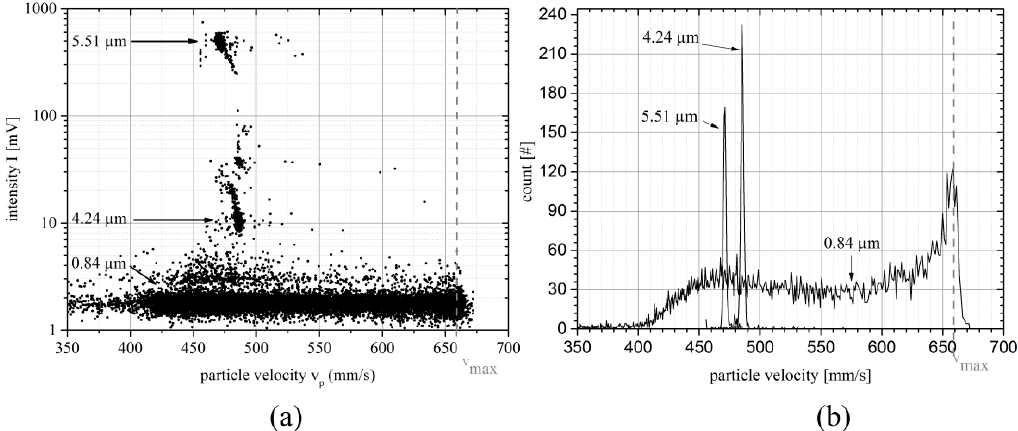
Figure 9. Particle suspension measurement: ( a ) Scatter plot of the intensity as a function of particle velocity of a suspension containing particles with mean diameters of 5.51 µm, 4.24 µm and 0.84 µm. The vertical dashed line is an auxiliary line showing the maximum theoretical channel velocity of the center stream line. ( b ) Velocity distribution of the 0.84 µm, 4.24 µm particles and 5.51 µm particles.